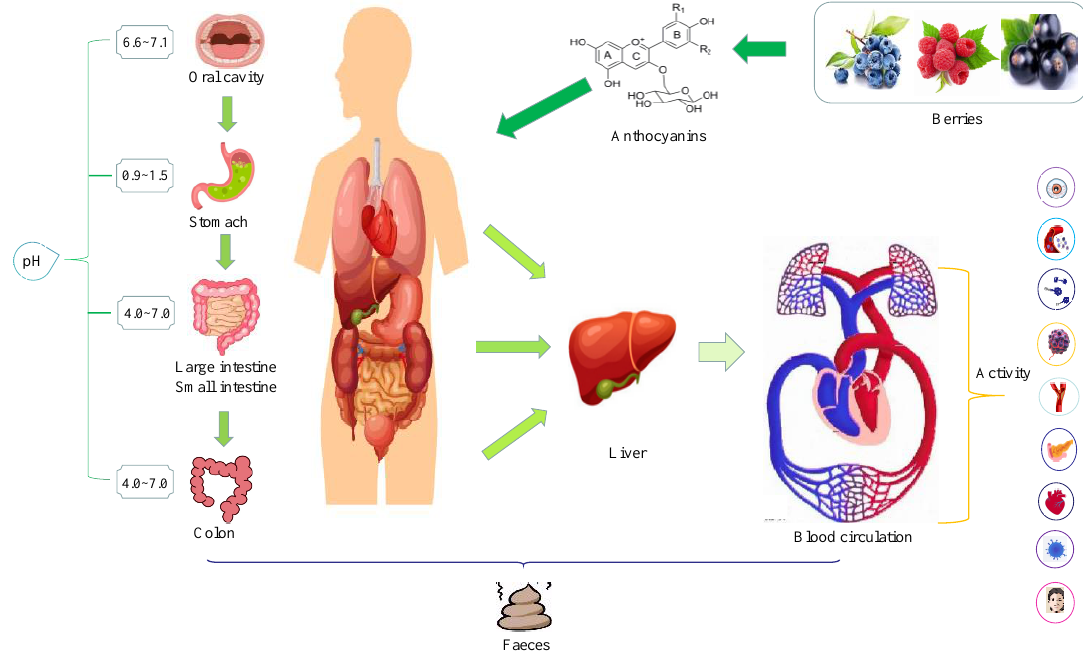
Figure 3. The absorption and metabolism of berry anthocyanins in the human body. F i g u r e 1 . A n t ho c y a n i n a b s o r p ti on a nd m e t a bo li s m Digestion of food, including anthocyanins, begins in the oral cavity. Upon exposure to human saliva, the degradation of anthocyanins in various berries ranged from 8 to 90%, with the mean exceeding 10% within 5 min. The pH value in the oral cavity is generally 6.6~7.1. Human oral surface epithelial cells and salivary gland terminal ducts secrete hydrolases, second stage enzymes (uridine diphosphate glucuronosyltransferase), and efflux transport enzymes required by local intestinal circulation similar to those in the small intestine, which degrades some anthocyanins into different products [41]. Walle found that the cytoplasm and oral microorganisms isolated from oral epithelial cells could degrade intact flavonoid glycosides (genistein) into aglycones, and β -glucosidase is the key enzyme for degradation in this process [42]. The oral digestion of anthocyanins is limited because anthocyanins stay in the oral cavity for a short time. The enzymes related to oral endocrine enter the alimentary canal with anthocyanins, which makes anthocyanins further digested and absorbed [43]. The undigested anthocyanins in the oral cavity enter the stomach through the upper alimentary canal. The acidic gastric juice in the stomach is a favorable environment for the stability and absorption of anthocyanins. Anthocyanins can be rapidly absorbed in the stomach without hydrolysis and appear in plasma within 30 min after ingestion [44]. The pH value of stomach environment is generally 0.9~1.5. Anthocyanins are relatively stable in the form of flavylium AH + at pH ≤ 2. Approximately 1%~10% of anthocyanins are absorbed by gastric epithelial cells in a complete structure [45]. In addition, 10~20% of anthocyanins are actively transported to the blood circulation through gastric epithelial cells in the form of primary metabolites [46]. Numerous studies have indicated that the stomach is an important part of anthocyanin absorption, and the stomach’s absorption rate of anthocyanins could reach 20% [47,48]. McGhie and Walton reported that the plasma anthocyanins concentration reached the highest value within 15 – 30 min after rats ingested anthocyanins through gastric intubation, suggesting that the stomach plays an important role in anthocyanin absorption [49]. Fernandes et al. showed that the absorption of anthocyanins by the stomach was limited to a certain extent. High concentration of anthocyanins led to saturation of gastric absorption, which proved that anthocyanins were absorbed actively with the participation of carriers [50]. However, the mechanism of anthocyanin absorption by the stomach is not clear, and it has been reported that this